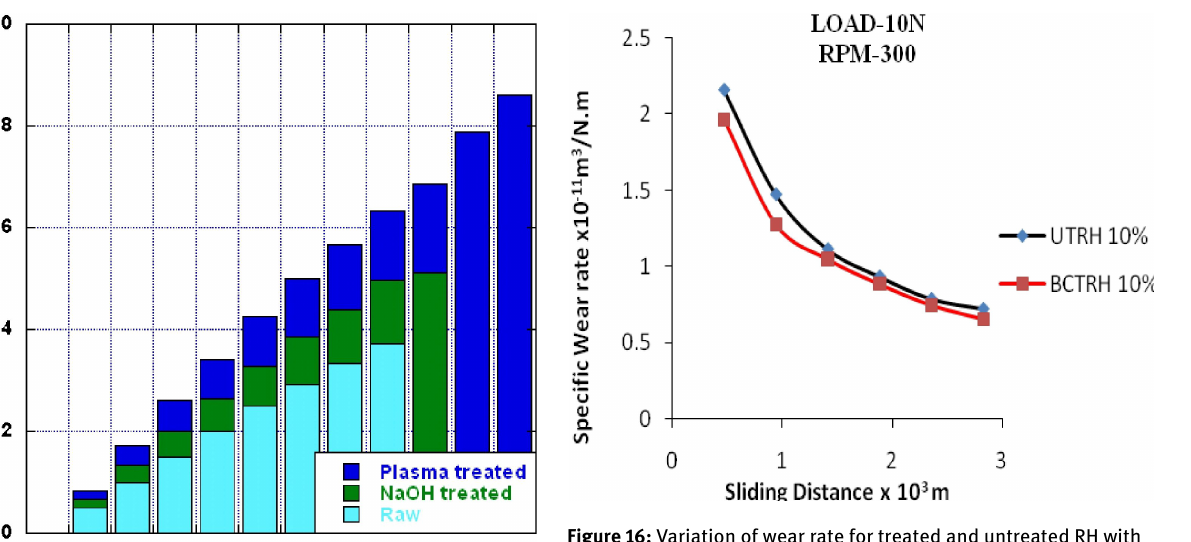
Figure 16: Variation of wear rate for treated and untreated RH with sliding distance